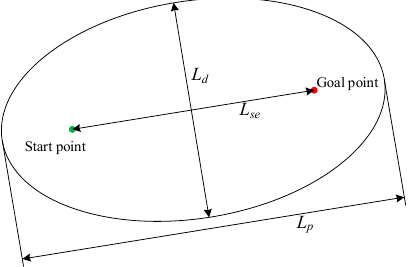
Figure 2. Diagram of ellipse sampling space construction.